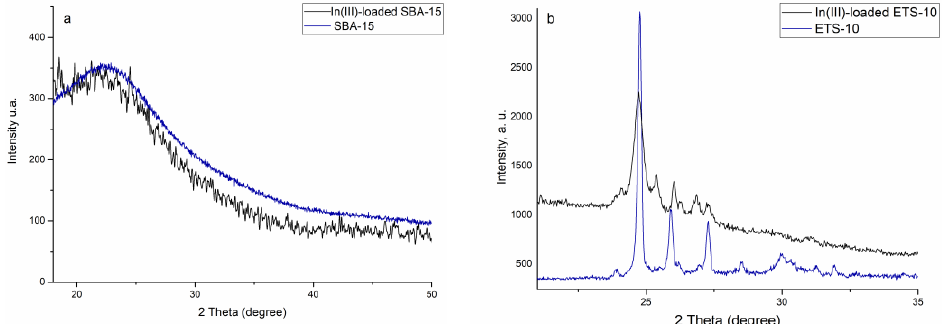
Figure 2. Figure 2. XRD patterns of ( a ) silica SBA-15 and ( b ) titanosilicate ETS-10 before and after In(III) - adsorption.